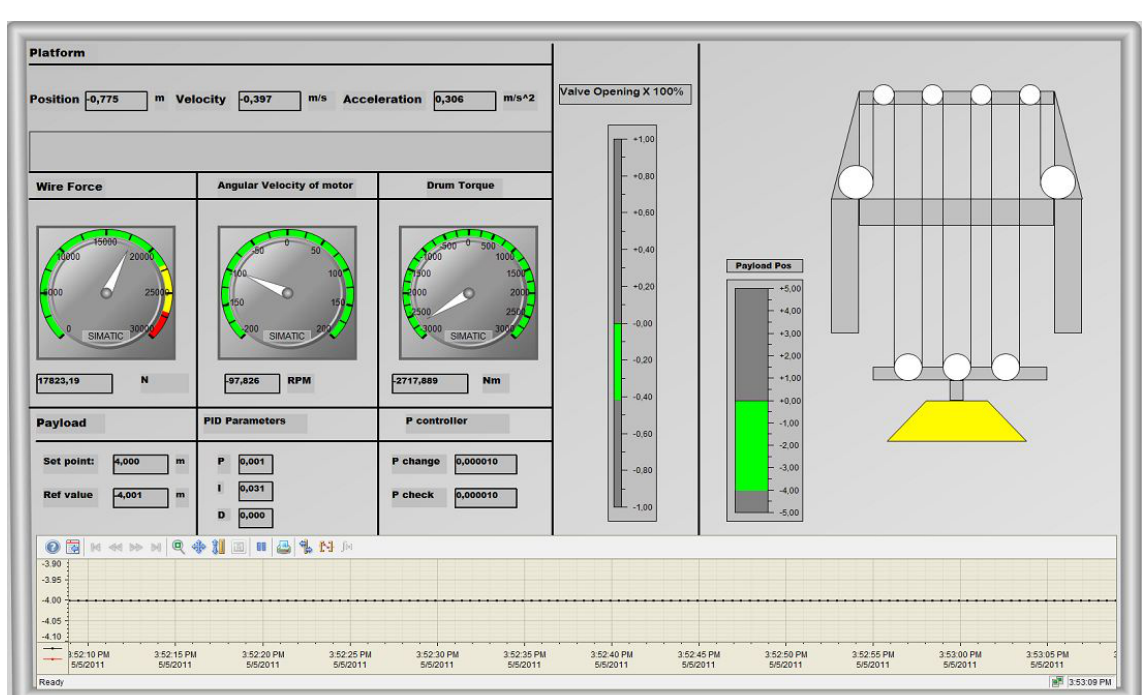
Figure 11. Graphical user interface for the AHC